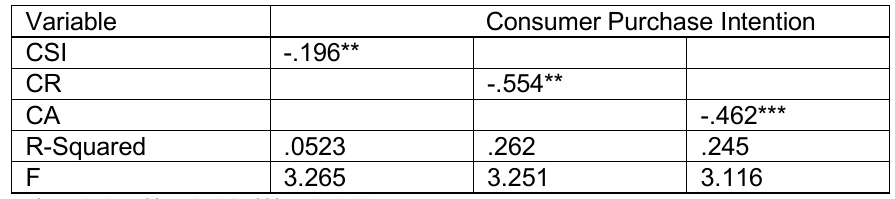
Table 3: Independent regression between independent variables,